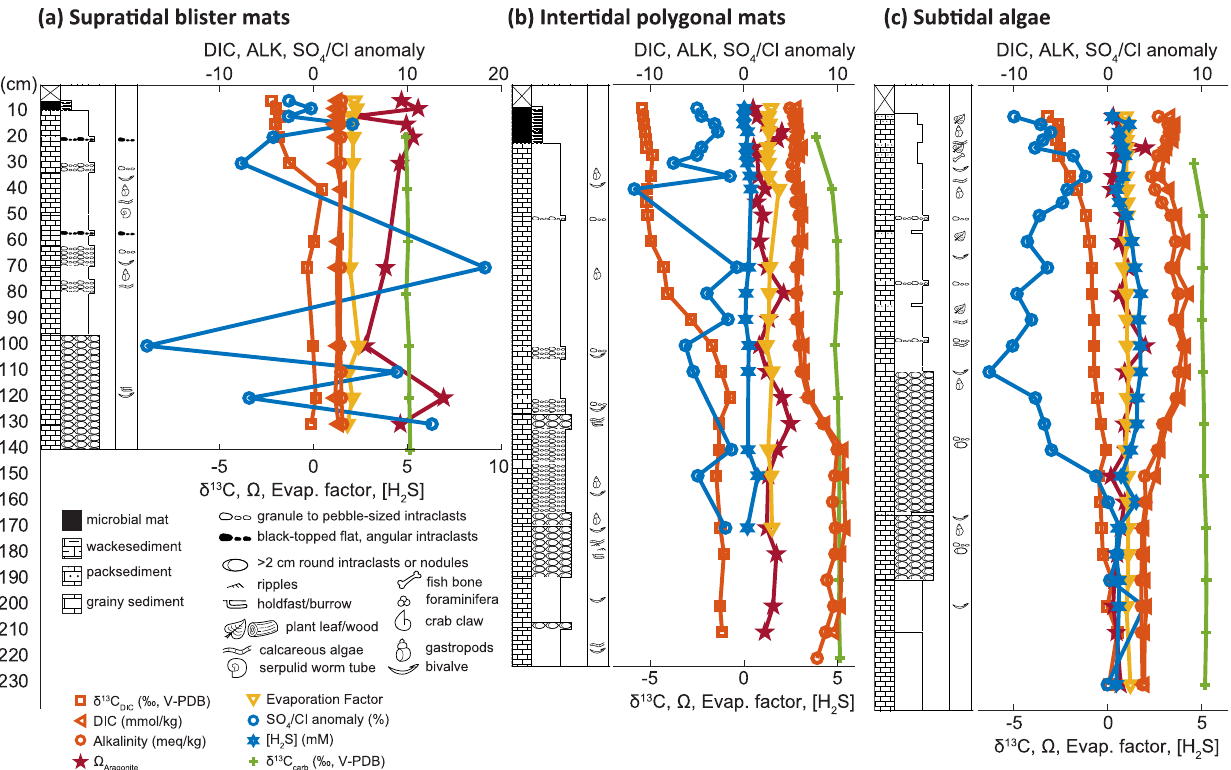
Fig. 3 Sedimentology and geochemistry of vibracores. Geochemical data and graphic logs show the effects of tidal pumping and biogeochemical processes on aragonite saturation. Additional logs from cores without porewater sampling are shown in Supplementary Fig. 2 and Supplementary Fig. 3. Evap. = evaporation, ALK = alkalinity, V-PDB = Vienna Pee Dee Belemnite. a Core VC-01, situated in low supratidal mats on the fl ank of the eolian grainstone berm. b Core VC-03, located in intertidal polygonal mats near a mangrove thicket. c Core VC-04, situated in a subtidal, muddy Batophora algae patch.